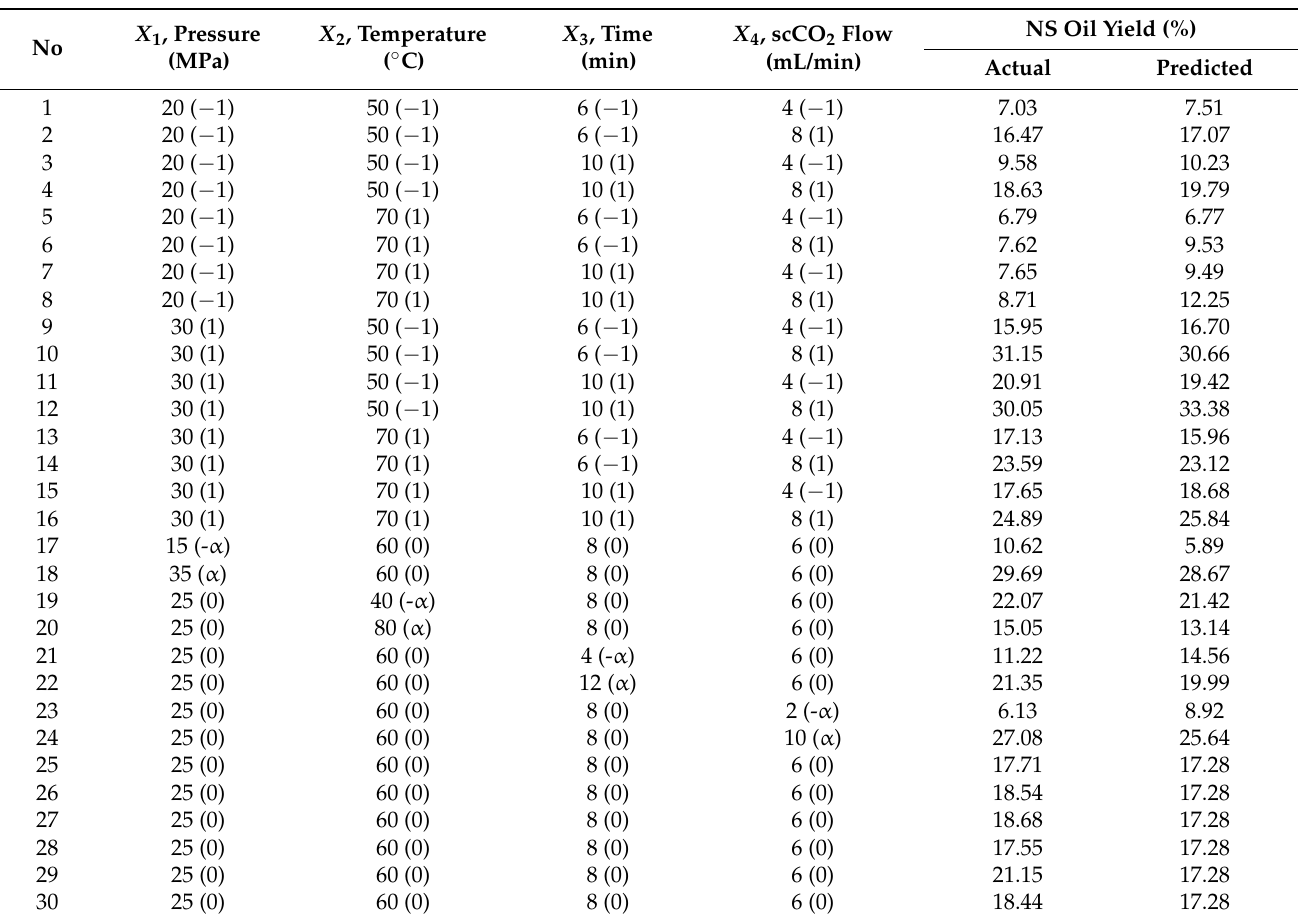
Table 1. Experimental matrix and results in central composite rotatable design 2 4 experiment; X 1 —pressure (MPa), X 2